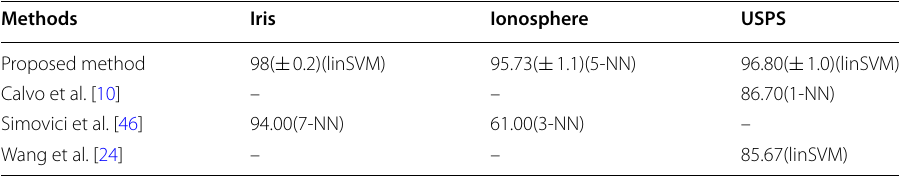
Table 9 Comparing the highest classification performance (accuracy in percent) of the proposed method with the recent similar approach (the values reported are the highest performance reported in each